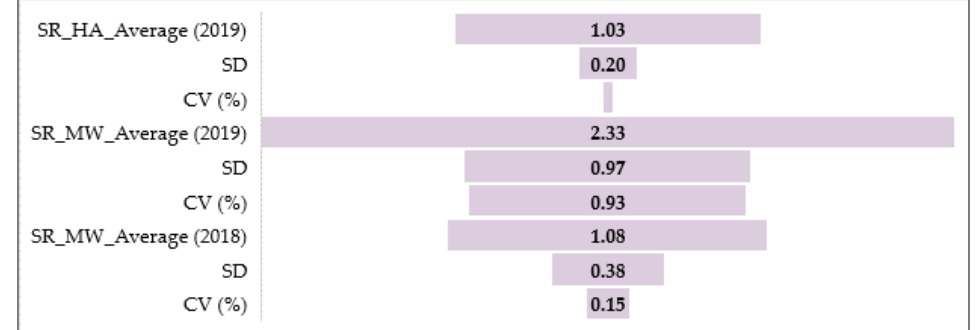
( C2 ) Figure 4. Powdery mildew (PM) resistance accessions belong to the sub-collections evaluated in 2018–2019 and their frequency distribution for the PM resistance scores. Figures ( A1 , B1, C1 ) present the results of the ANOVA ( p ≤ 0.05 ) and the bars represent the SD ( p ≤ 0.05 ). Figures ( B1 , B2,C2 ) present the regression analysis model estimating the relationship between the PM resistance scores and the frequency index. The sub-collections (groups) of accessions were created using two criteria: (1) cultivation period and registration of cultivars (group A—cultivated prior to 1985, B—cultivated after 1985 and C—Polish landraces) and (2) country of origin or geographical region: I—POL; II: CSK, DEU, DNK, AUT; III: FRA; IV: GBR, IRL; V: NLD, FIN, NOR; VI SWE; VII: other non-Euro- pean. 3.1.2. Barley Stem Rust